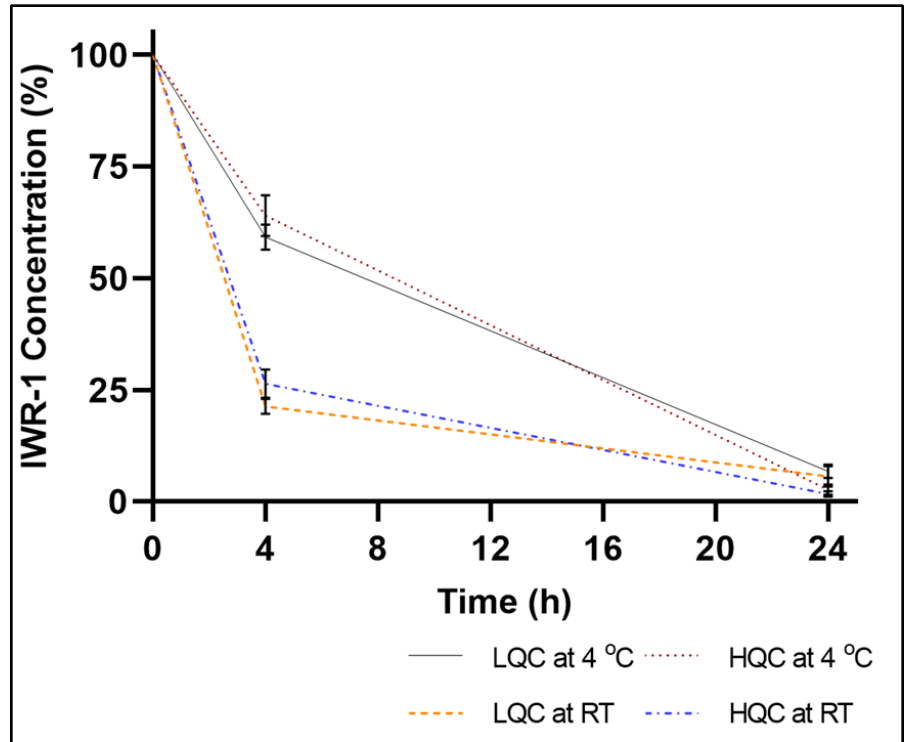
Figure 4. Time course of degradation of IWR-1 in murine plasma stored at 4 °C and room temperature over a period of 24 h (n = 3; mean ± S.D.). LQC: low-quality control; HQC: high-quality control; RT: room temperature.